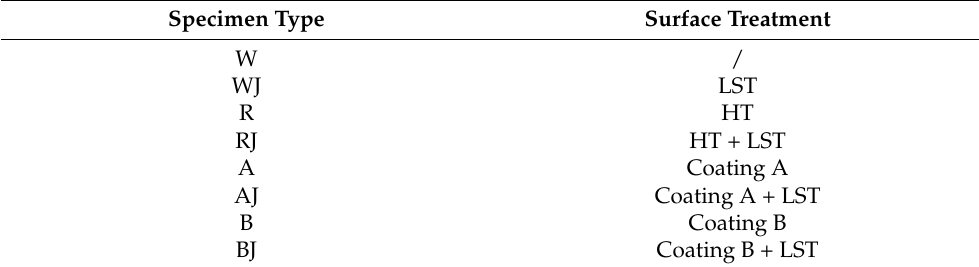
Table 3. Specimens fabricated in this work and their treatment.